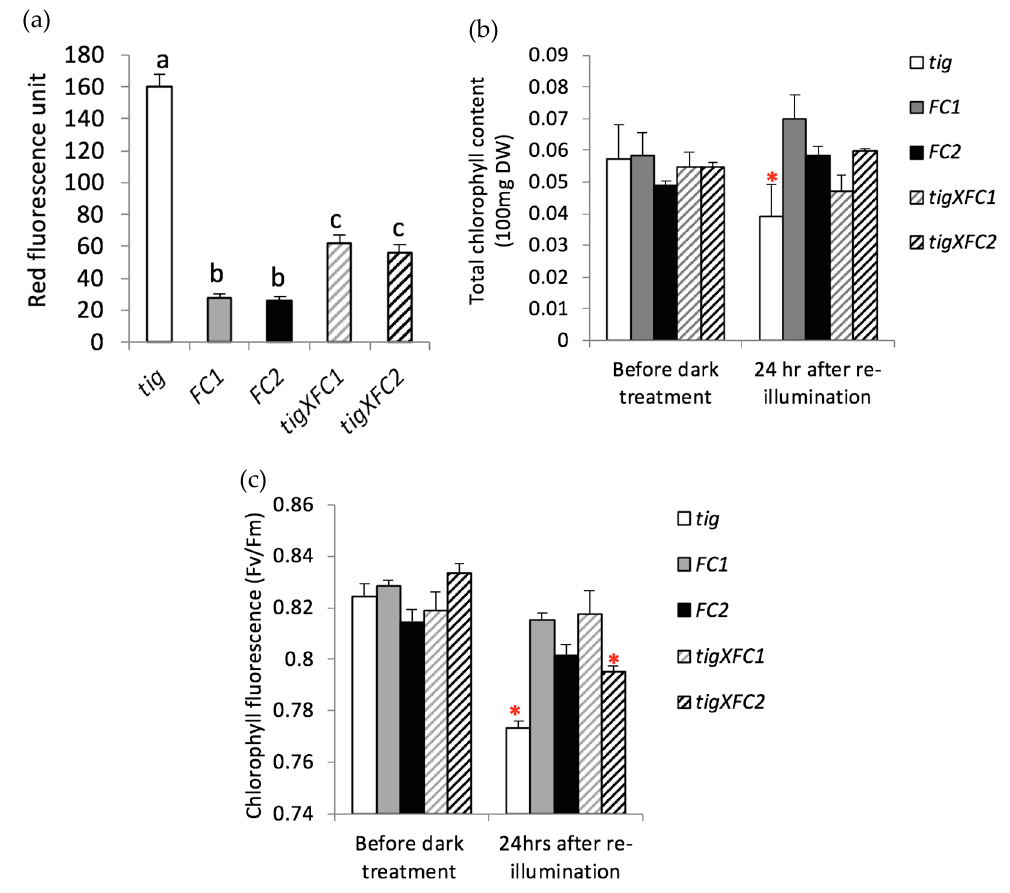
Figure 7. Ectopic overexpression of HvFC1 and HvFC2 suppresses tigrina d12 mutant phenotypes. ( a ) Red fluorescence of dark grown seedlings, which is an indication of the level of Pchlide accumulation. The data are shown as mean ± standard error of 5 different plants. Means with the same letter are not significantly different at * p < 0.05 based on one-way ANOVA. ( b ) Total chlorophyll content and ( c ) Chlorophyll fluorescence (F v /F m ) before dark treatment and upon 24 hrs after re-exposure to light. The data are shown as mean ± standard error of 5 different plants. Asterisks indicate a statistically significant difference relative to before treatment, at * p < 0.05 based on two-way ANOVA. tig - tigrina d12 mutant. FC1, FC2 - representative transgenic lines ectopically overexpressing either HvFC1 or HvFC2 . tig × FC1 or tig × FC1 - tigrina d12 mutants ectopically overexpressing either HvFC1 or HvFC2 .